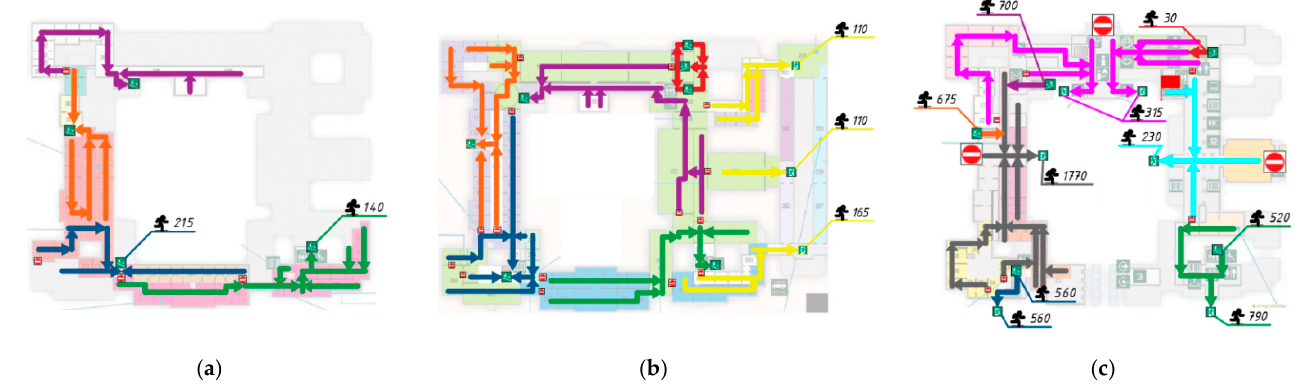
Figure 14. Scheme of evacuation of people from the Winter Palace for the scenario “Fire in buffet”: ( a ) for the 3rd floor; ( b ) for the 2nd floor; and ( c ) for the 1st floor.